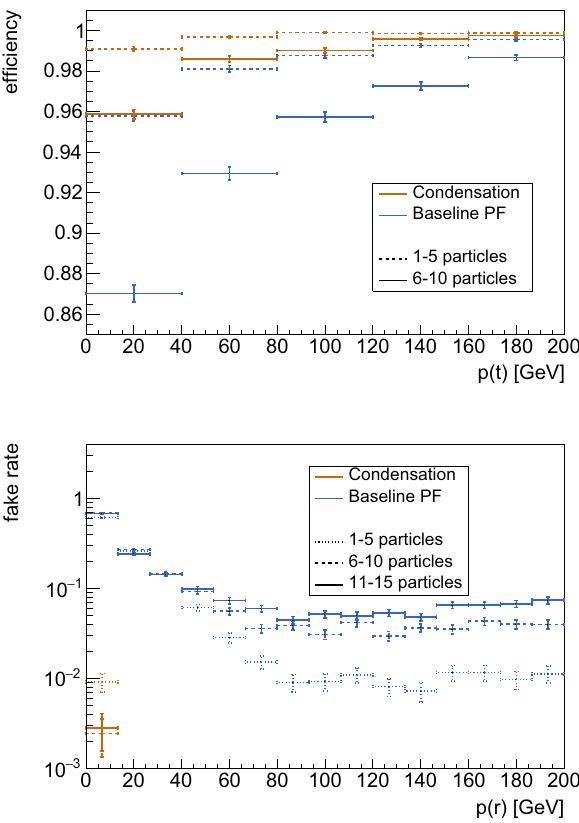
Fig. 4 Top: efficiency to reconstruct an individual particle as a func- tion of its true momentum p ( t ) . Bottom: fraction of reconstructed par- ticles that cannot be assigned to a truth particle as a function of the reconstructed particle momentum p ( r ) . Both quantities are shown for different numbers of particles per